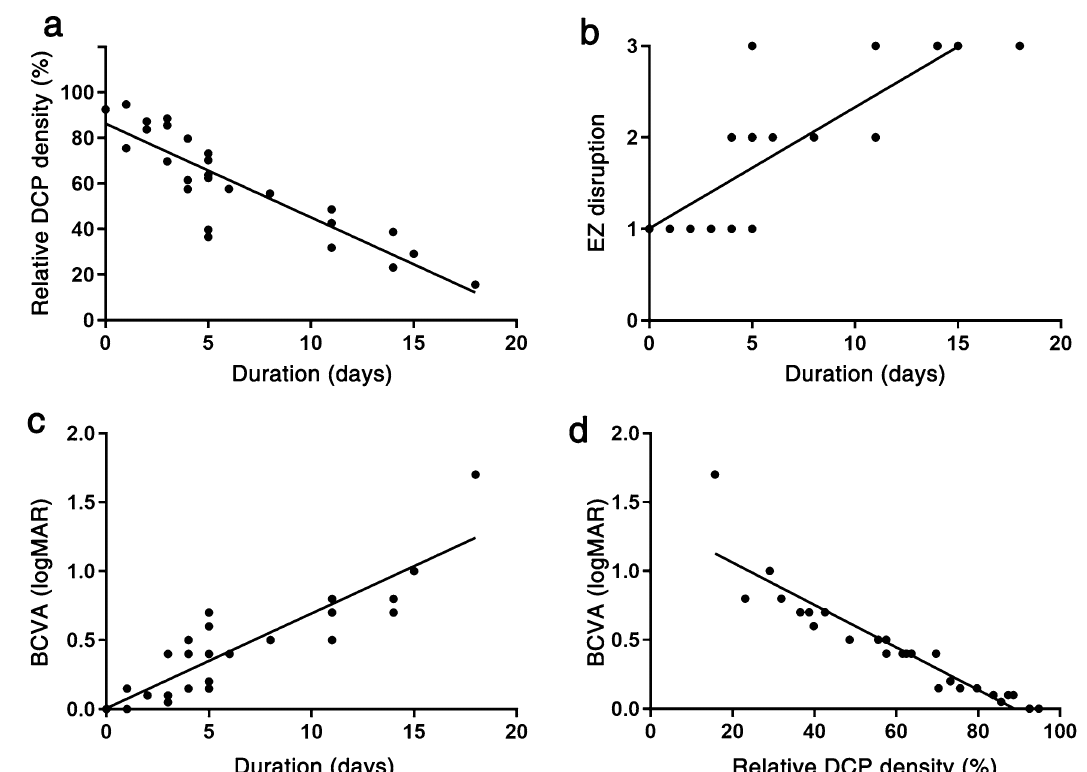
Figure 2. Association of optical coherence tomography angiography parameters and visual prognosis in relation to duration of detachment in macula-off rhegmatogenous retinal detachment. As the duration of macular detachment increased, the macular deep capillary plexus (DCP) density, ellipsoid zone (EZ) integrity, and visual acuity (VA) worsened. Eyes that could be reattached promptly showed good DCP density, EZ integrity and visual acuity ( a – c ). Relative DCP density ( a ) is defined that DCP proportion of the RRD eye compared to the normal control eye (fellow eye). DCP density was revealed to be strongly correlated with visual acuity ( d